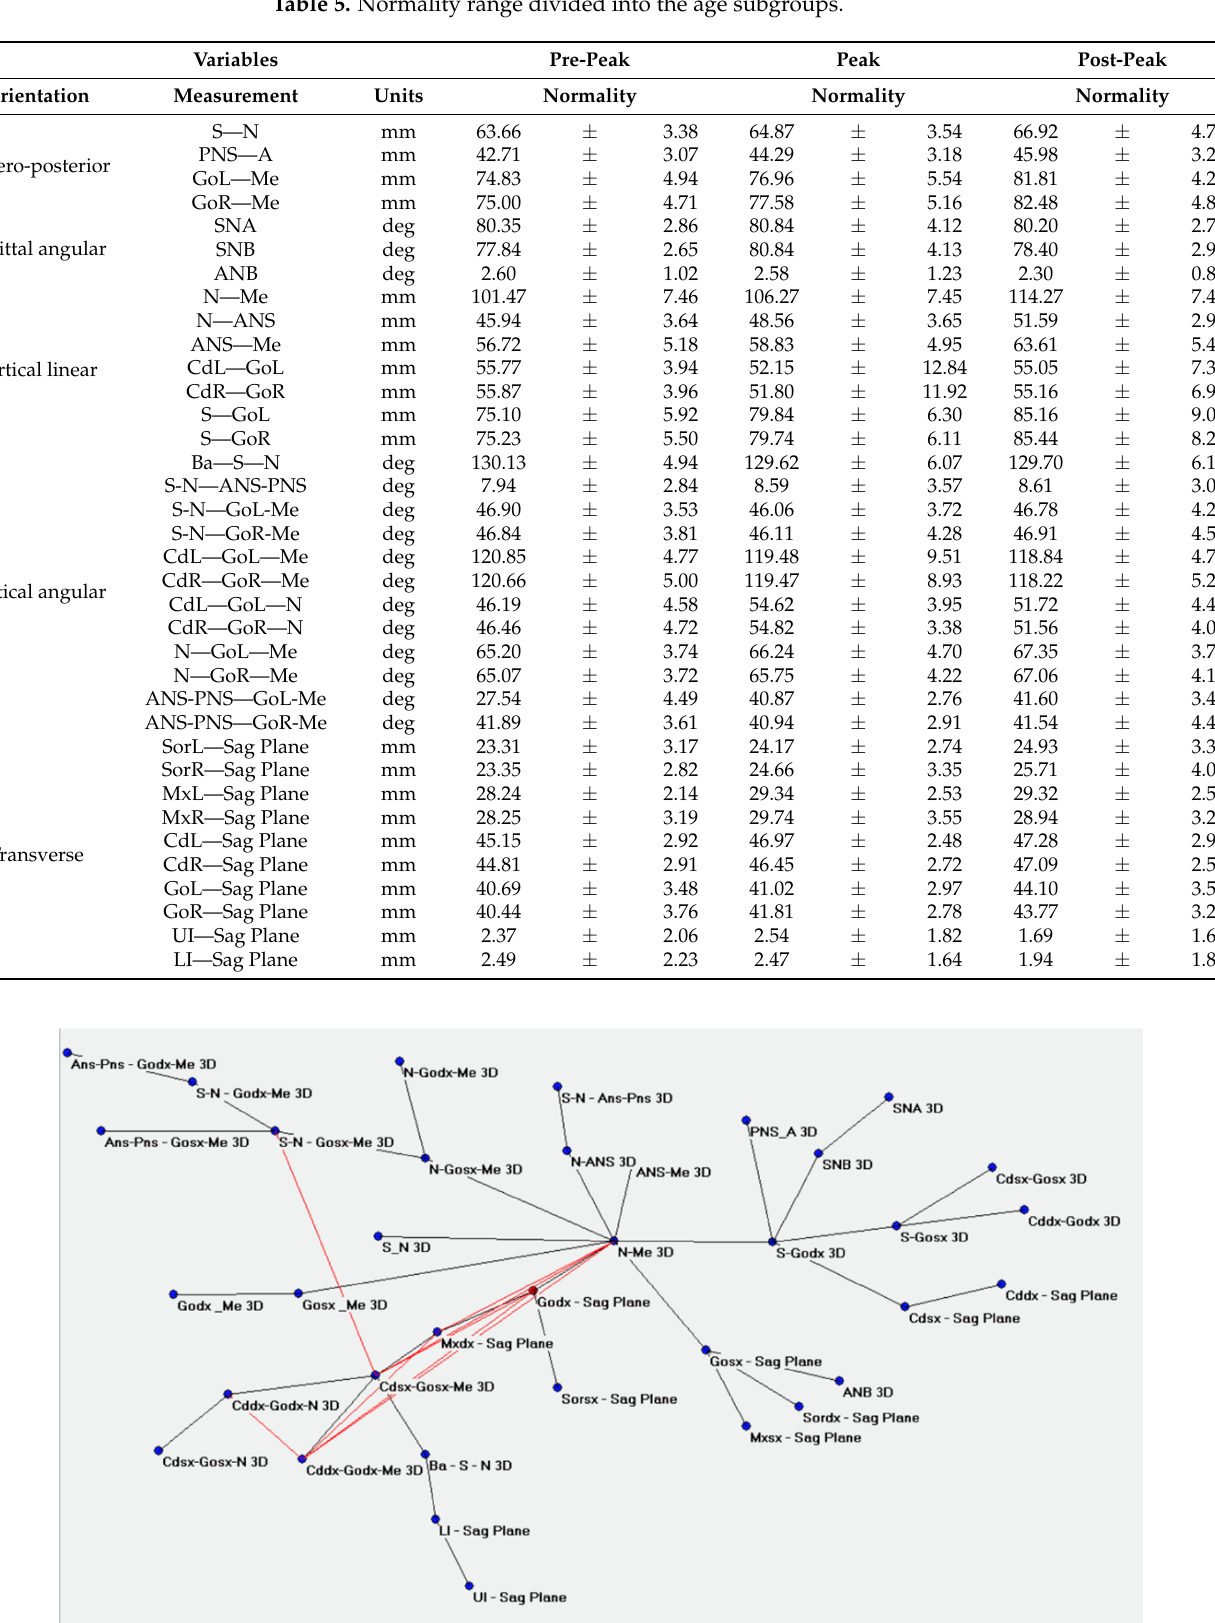
Figure 3. Betweenness centrality displayed on Pajek, calculated with Auto Contractive Maps.